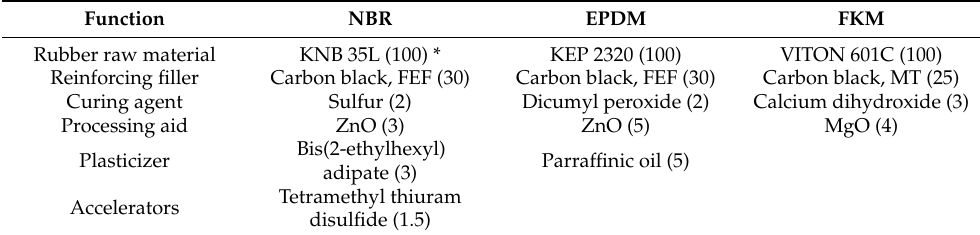
Table 1. Functions and chemical compositions in NBR, EPDM, and FKM